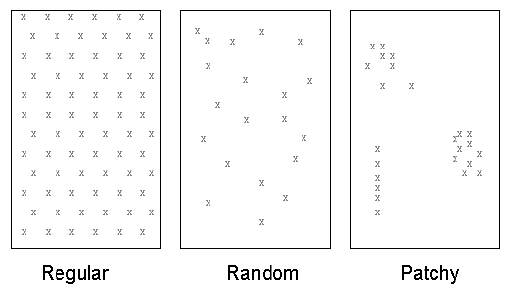
Figure 1. Weed distribution cases in the agriculture field (Hassanein and El-sheimy, 2017)